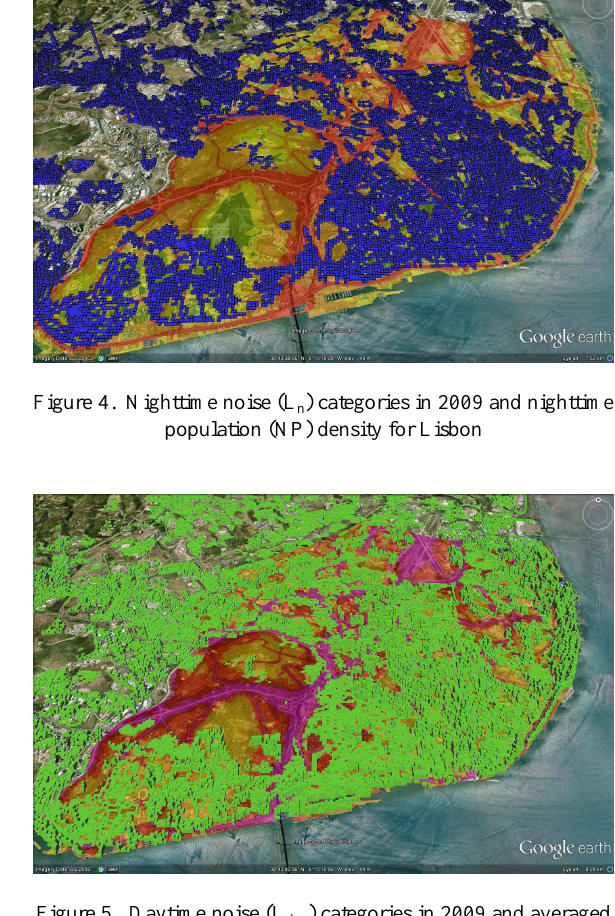
Figure 5. Daytime noise (L den ) categories in 2009 and averaged population (AP) density for Lisbon